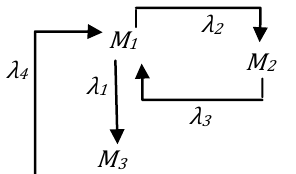
Figure 7. Markov chain isomorphic to SPN